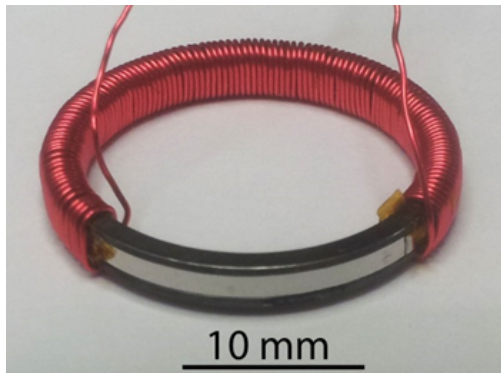
Figure 2. An S1000-compatible fluxgate ring core. The red enam- eled wire forming the drive winding has been partially removed for the photograph, exposing the ferromagnetic sense element (silver) and the supporting bobbin